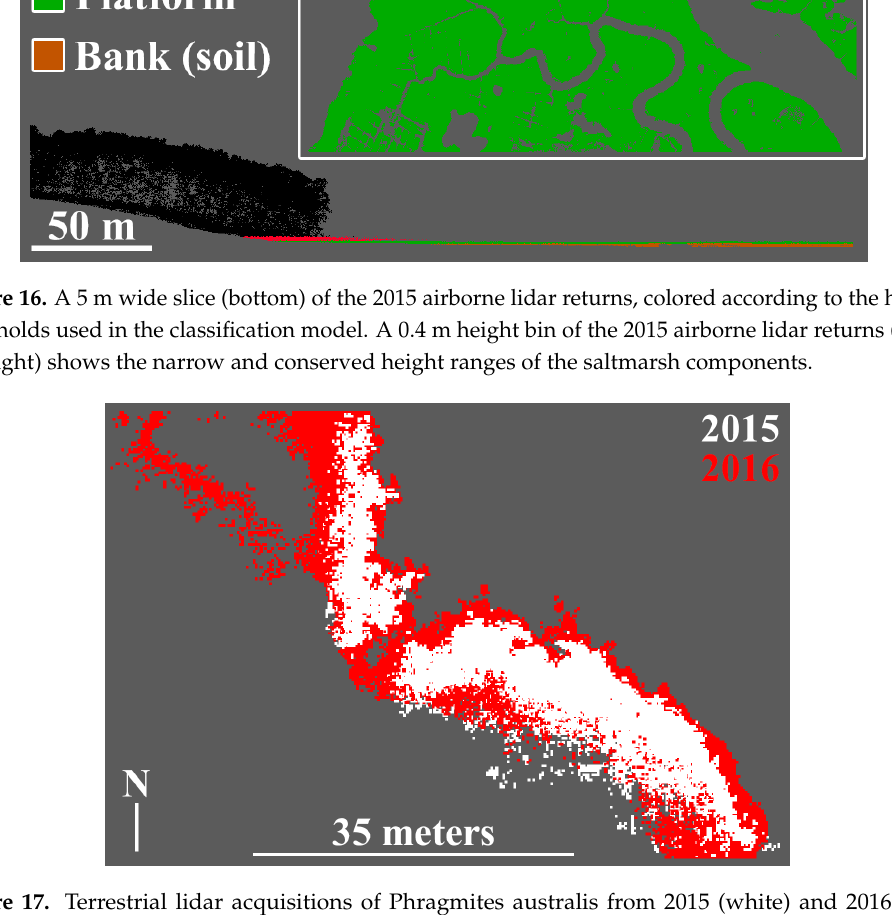
Figure 17. Terrestrial lidar acquisitions of Phragmites australis from 2015 (white) and 2016 (red) showing the expanded extent (0.25 m resolution).